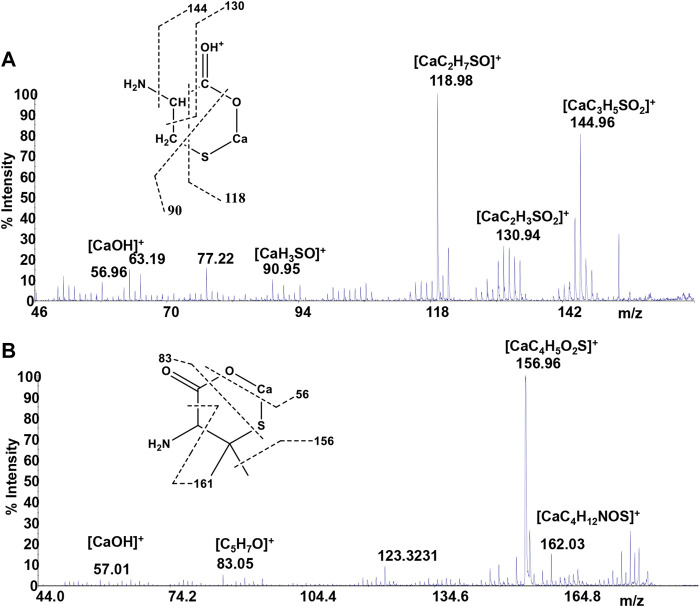
MS/MS spectrum of (A)
Cys and (B)
PSH in the presence of Ca2+.